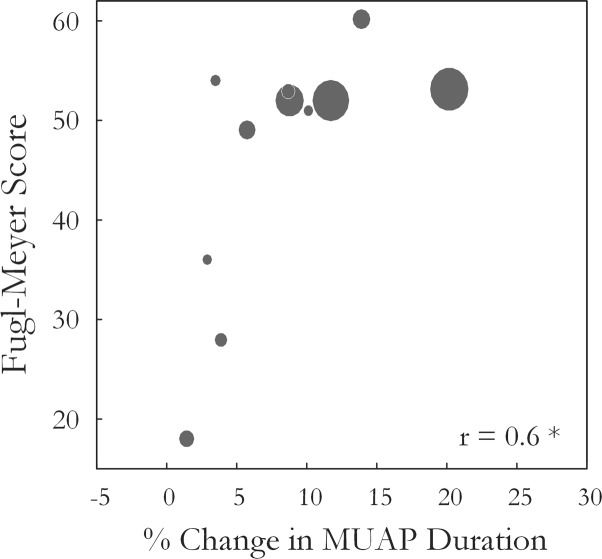
The Wrist and Hand Upper Extremity Fugl-Meyer score for each subject is plotted against the percentage change in median MUAP duration from pre- to post-fatigue observed for that subject (r = 0.6, p = 0.04). Larger circles indicate longer times to task failure for the sustained fatiguing contraction.